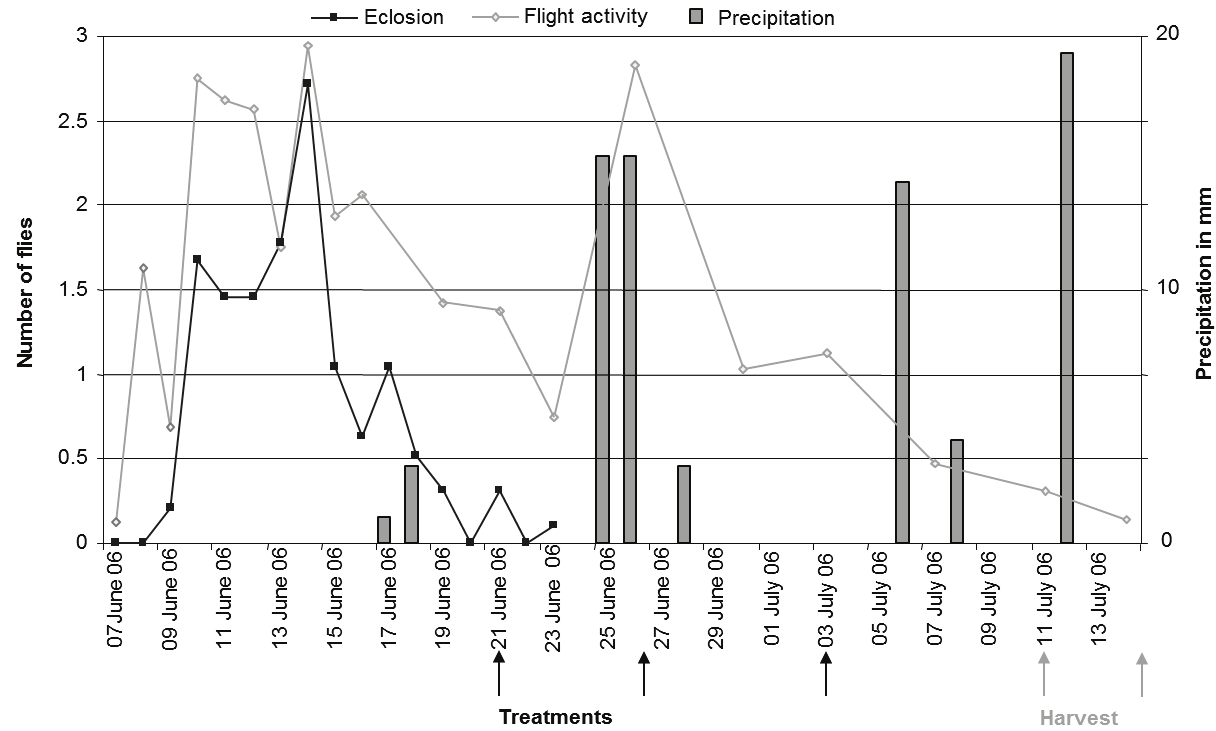
Figure 4. Field experiment: Eclosion of flies monitored by photo-eclectors (number of flies per 5 m 2 per day); flight activity monitored by yellow sticky traps (number of flies per yellow sticky trap per day); dates of application and harvest as well as precipitation (mm) during the experimental